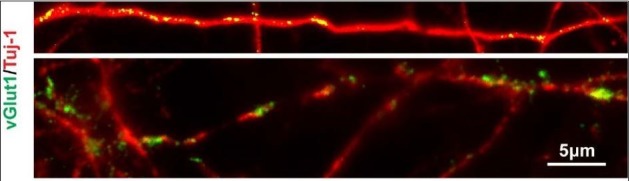
V-LHX6 OE neurons also received a small amount of excitatory inputs by vGlut1.